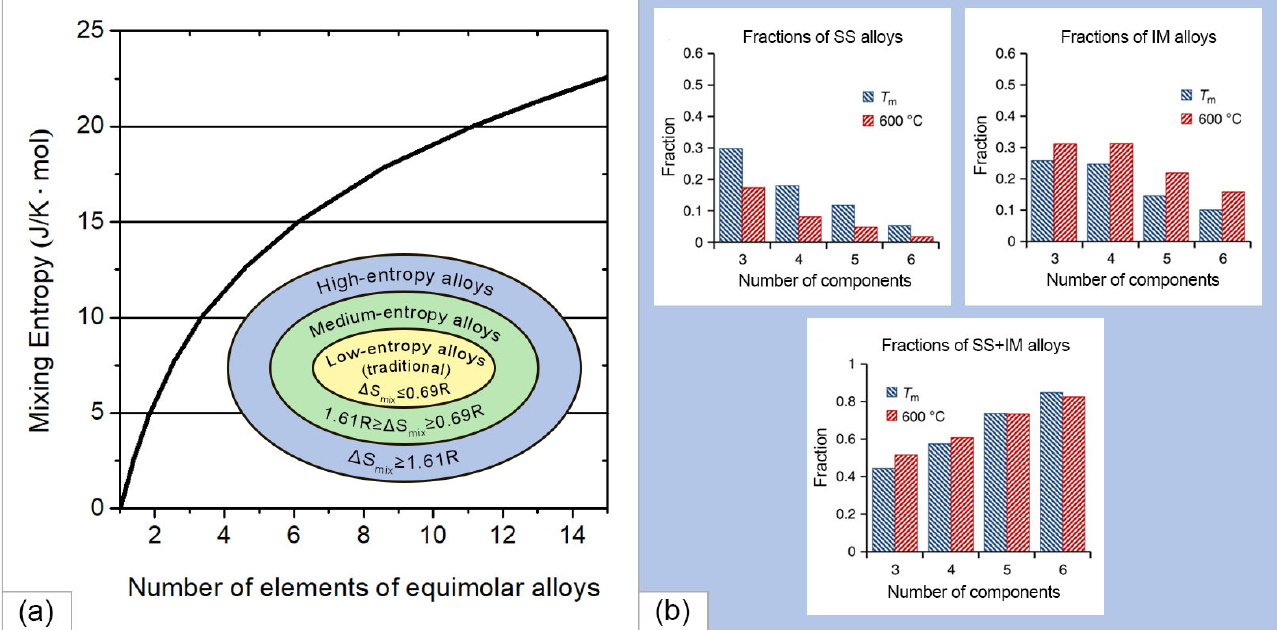
Figure 3. ( a ) The ratio between the entropy of mixing and the number of elements in a completely disordered equimolar alloy and inset in ( a ) categories of alloys based on the entropy approach (constructed using the data presented in [30] with permission of the LAVOISIER); ( b ) calculated fraction of different type of alloys on the number of components at the melting temperature ( T m ) and at 600 ◦ C (reproduced from